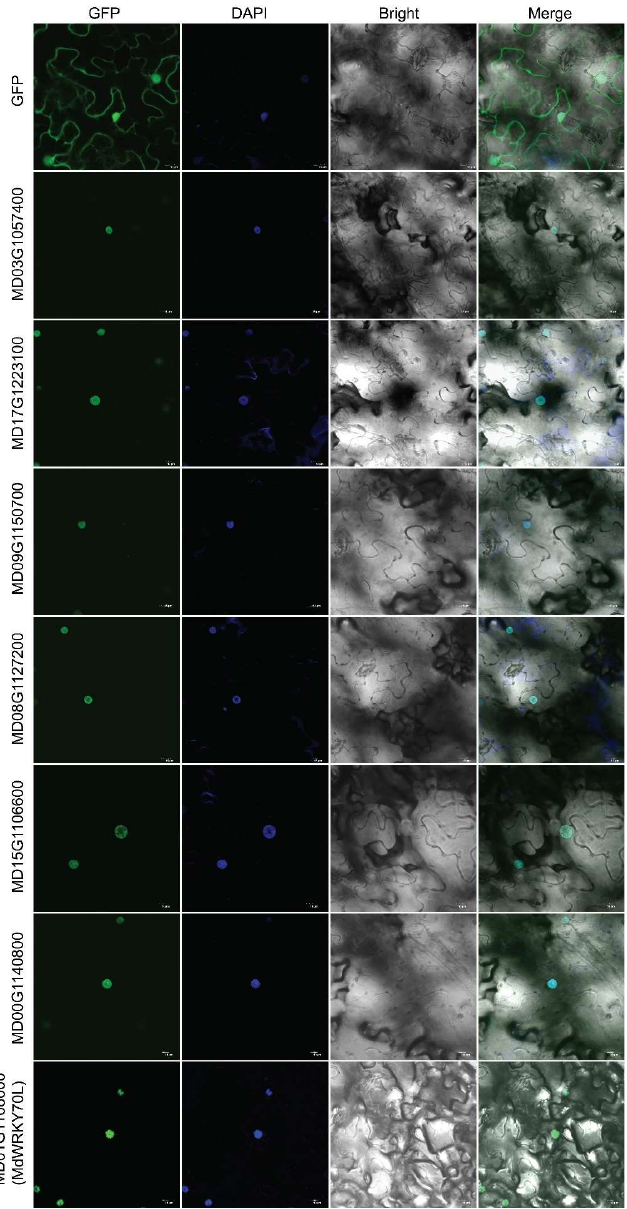
Figure 7. Subcellular localization analysis of seven MdWRKYs. The MdWRKY-GFP proteins and GFP proteins alone were expressed in tobacco leaf cells, respectively. The fluorescence was detected using a confocal microscopy under bright field and fluorescence. DAPI staining of cells was viewed under fluorescence, too. Scale bar = 15 μm.